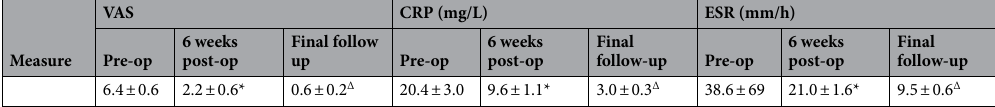
Table 3. Measures of surgical outcomes of the single posterior approach. VAS, visual analogue scale; ESR, erythrocyte sedimentation rate; CRP, C-reactive protein; Pre-op, Preoperative; Post-op, Postoperative. * P < 0.05 versus preoperative. Δ P < 0.05 versus 6 weeks’